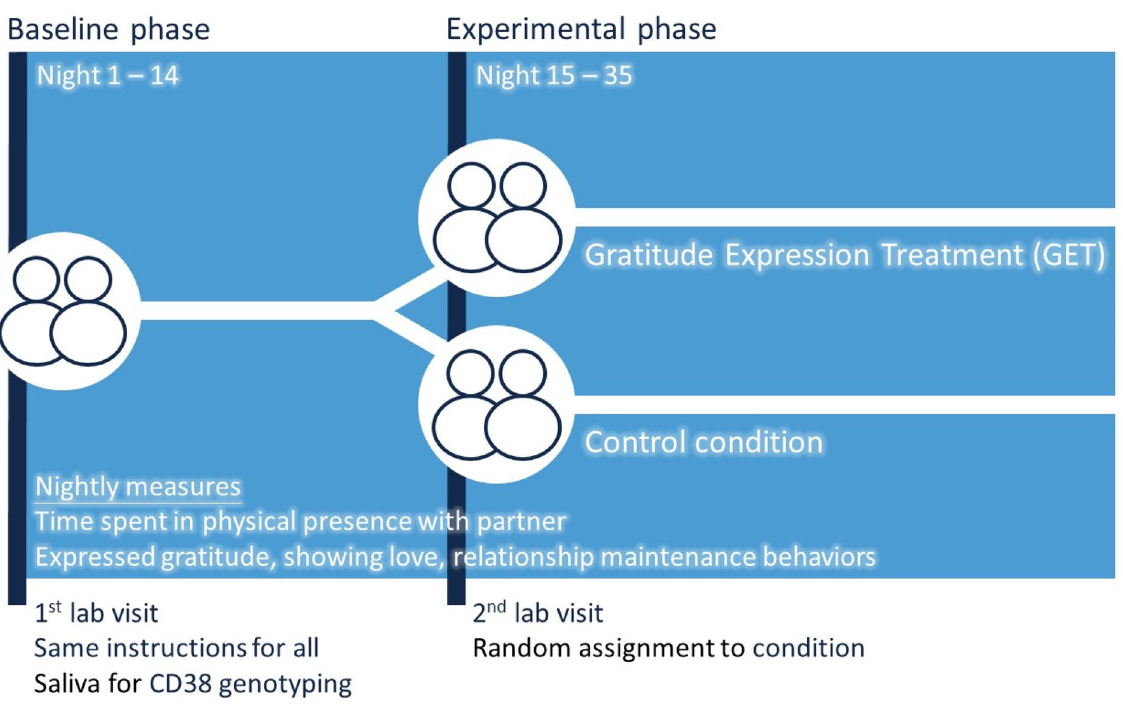
Figure 1. Overview of 5-week experimental protocol. 250 individuals from 125 couples completed the 5-week protocol, resulting in 28.65 of 35 possible nightly reports per person, on average, or 7162 observations.